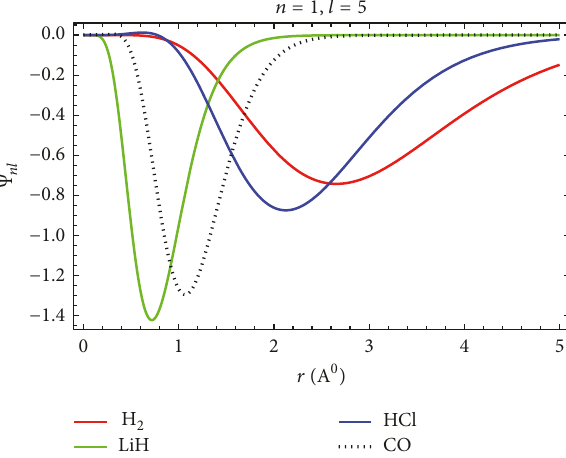
Figure 6: Wave function plot for the interaction potential with orbital angular quantum number 𝑙 = 3 .